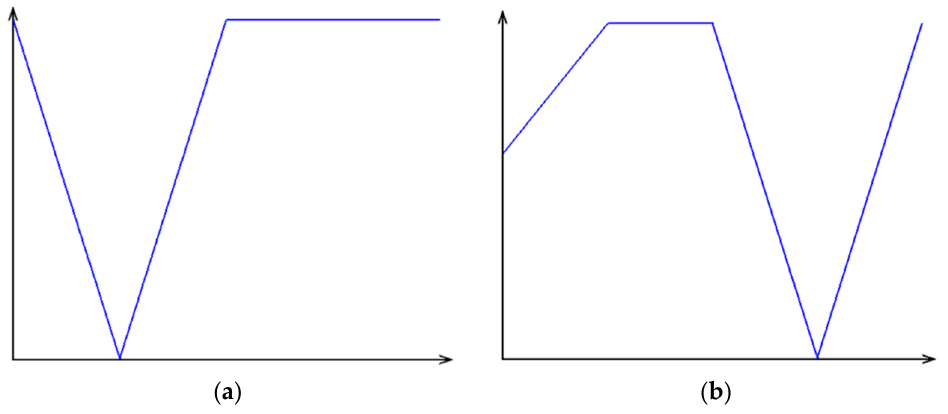
Figure 3. A comparison of 5 input parameters for test ( a ) 72 and ( b ) 84 carried out within 30 min. Table 9. The graphical evaluation of matching the model of output parameters to empirical data according to the assumptions included in test 72 and 84 (red line—output values of the neural network obtained as a result of the learning process, blue line—empirical values).